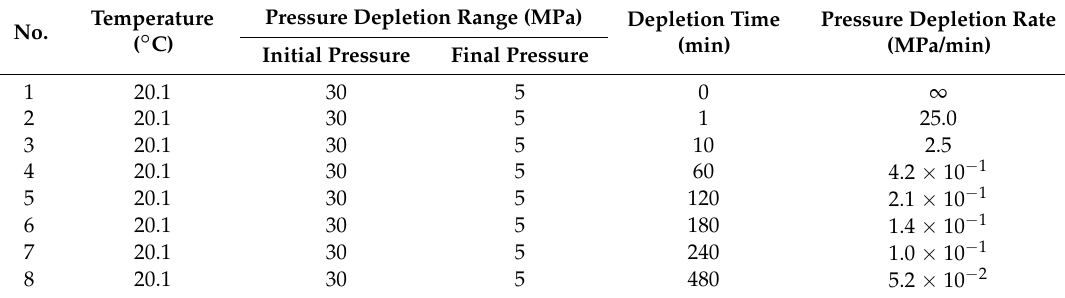
the cases of formation pressure coefficient equal to